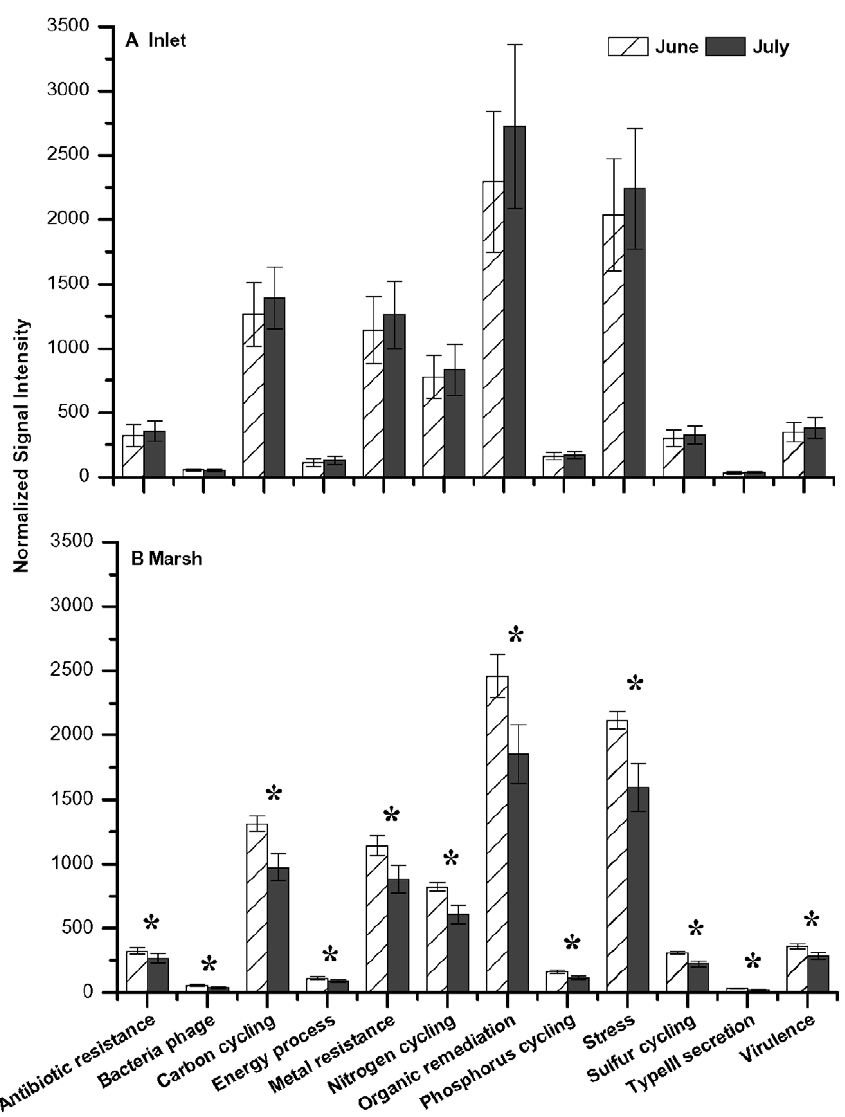
Figure 6. Functional gene distribution in Inlet and Marsh sediments. Gene relative abundance determined by GeoChip for samples compared between June and July 2010. Categories with significant changes indicated by *for p , 0.05.